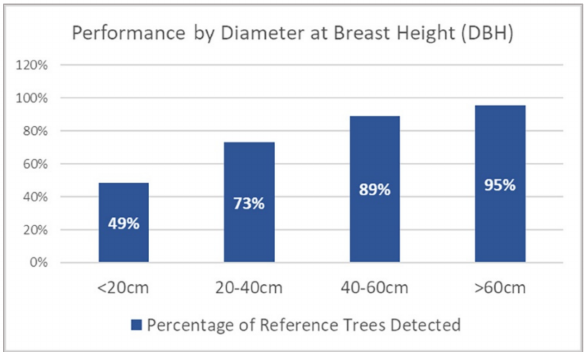
Figure 15. Tree detection performance for various DBH